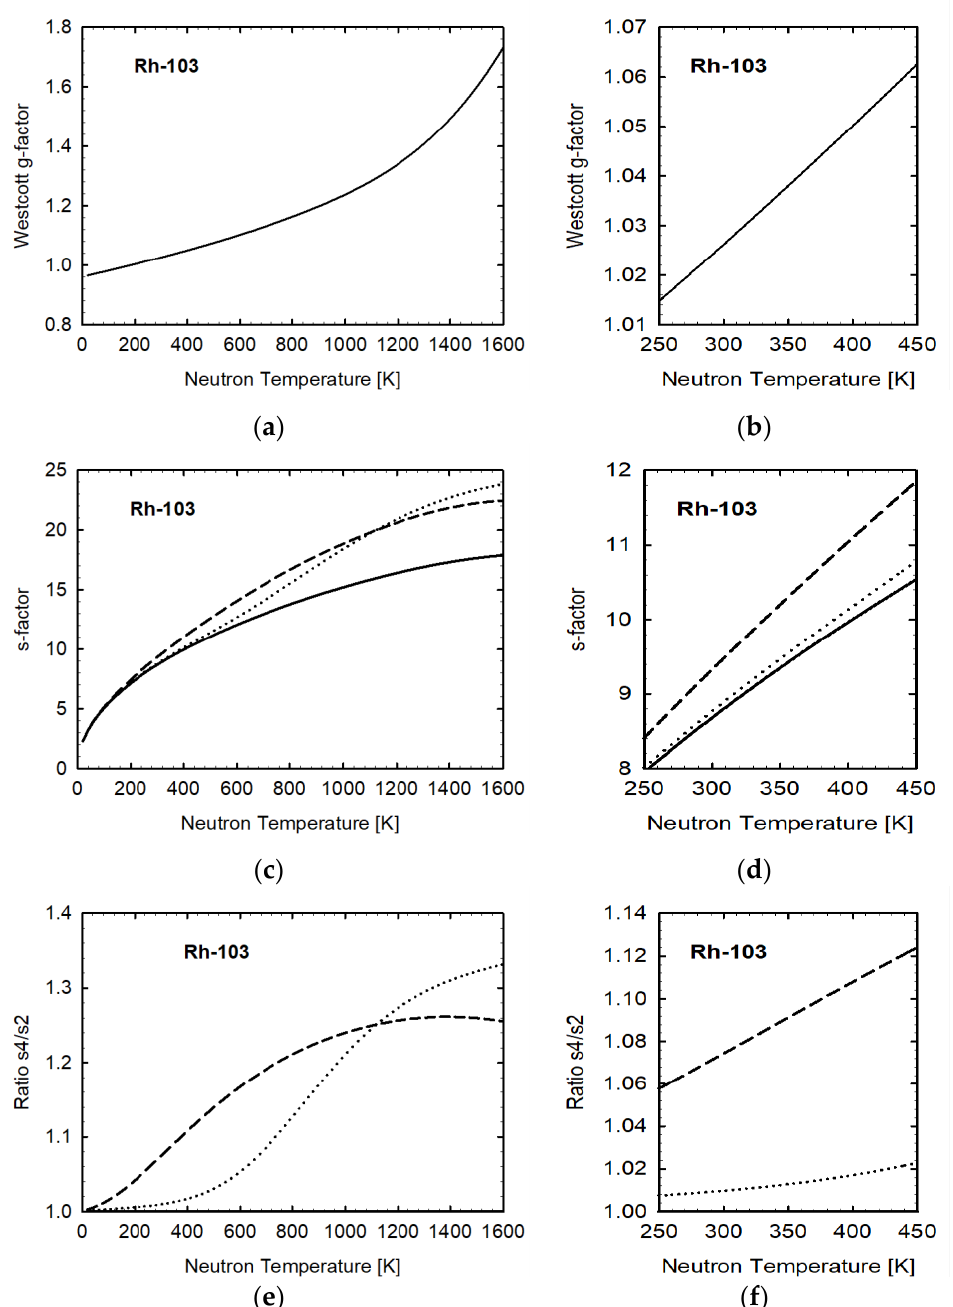
Figure 10. ( a ) Westcott g-factor for 103 Rh as a function of neutron temperature 𝑇 𝑛 ; ( b ) Expanded figure of ( a ); ( c ) s-factors, s 2𝑊 (solid line), s 4𝑊 (dotted line), s 4𝐻 (dashed line) for 103 Rh as a function of neutron temperature 𝑇 𝑛 ; ( d ) Expanded figure of ( c ); ( e ) Ratios of s-factors, s 4𝑊 /s 2𝑊 (dotted line) and s 4𝐻 /s 2𝑊 (dashed line) for 103 Rh; ( f ) Expanded figure of ( e ).